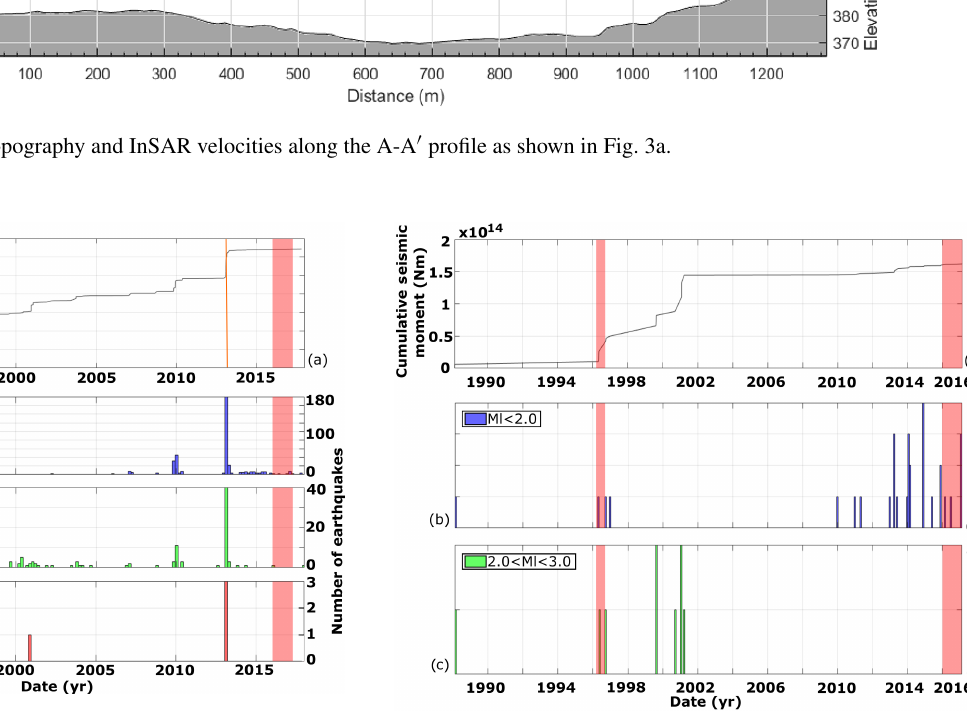
Figure 7. Seismicity of an area 3km in radius around the Prà di Lama lake. Plot of the cumulative seismic moment released in the area (a) and histograms showing the number of earthquakes oc- curred each month. Two different classes of magnitude have been created: M l < 2 . 0 (b) , 2 . 0 < M l < 3 . 0 (c) . No events of M l > 3 . 0 occurred in the area between 1986 and 2017. The red transparent bars indicate the two events of unrest of 1996 and